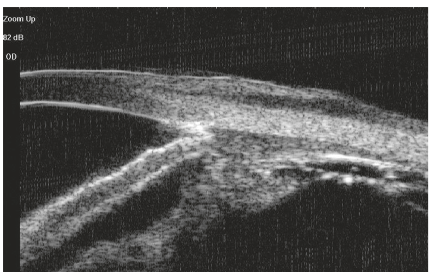
Figure 1: Image of UBM of a patient with glaucoma after PPV and SO injection showed an open chamber angle and several dotted high-echoes in the angle suggesting the SO